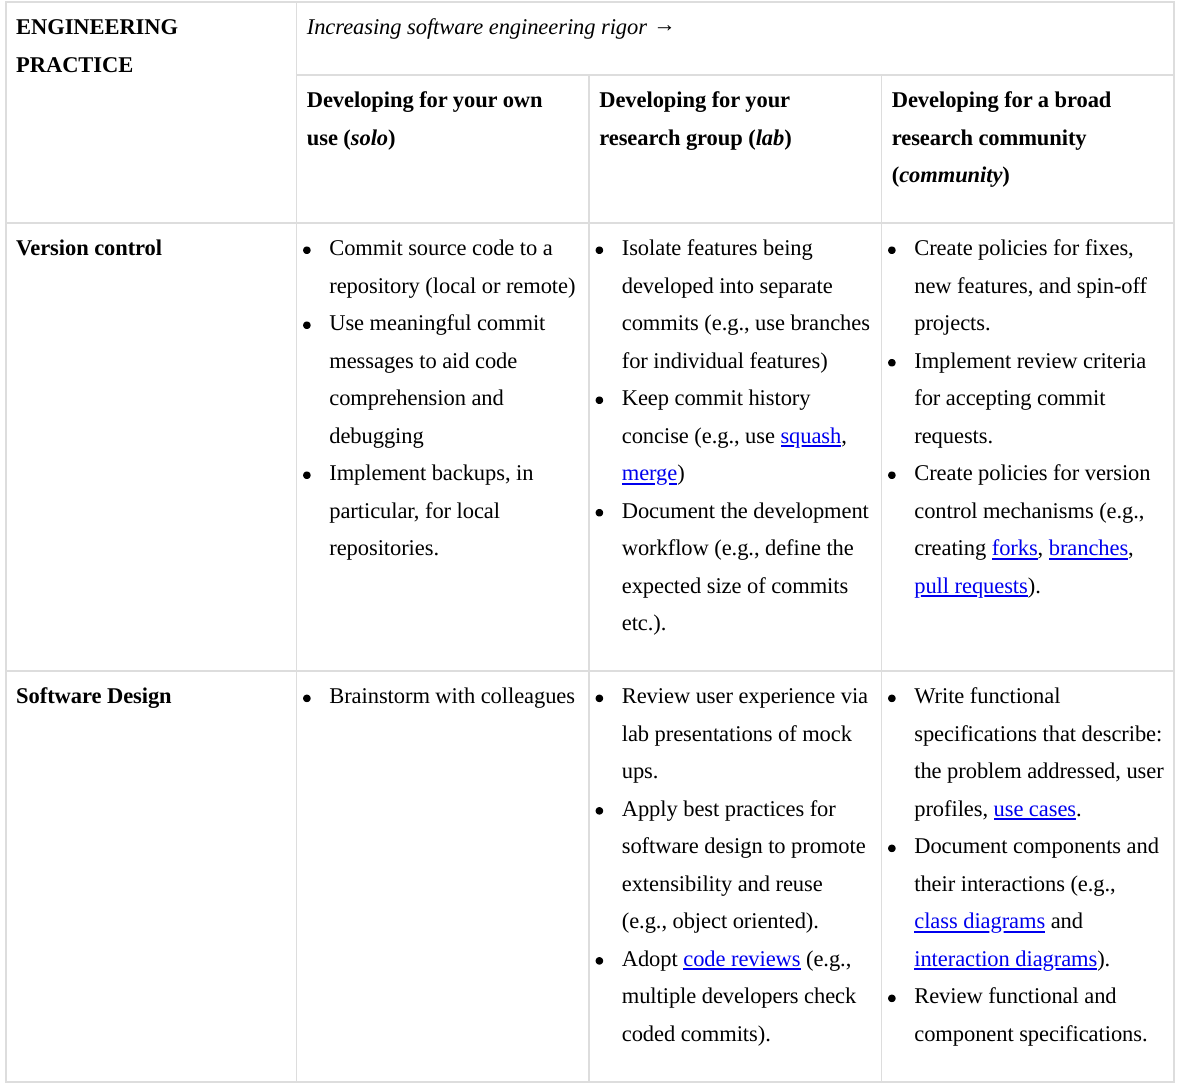
Table 1. Software engineering practices and project